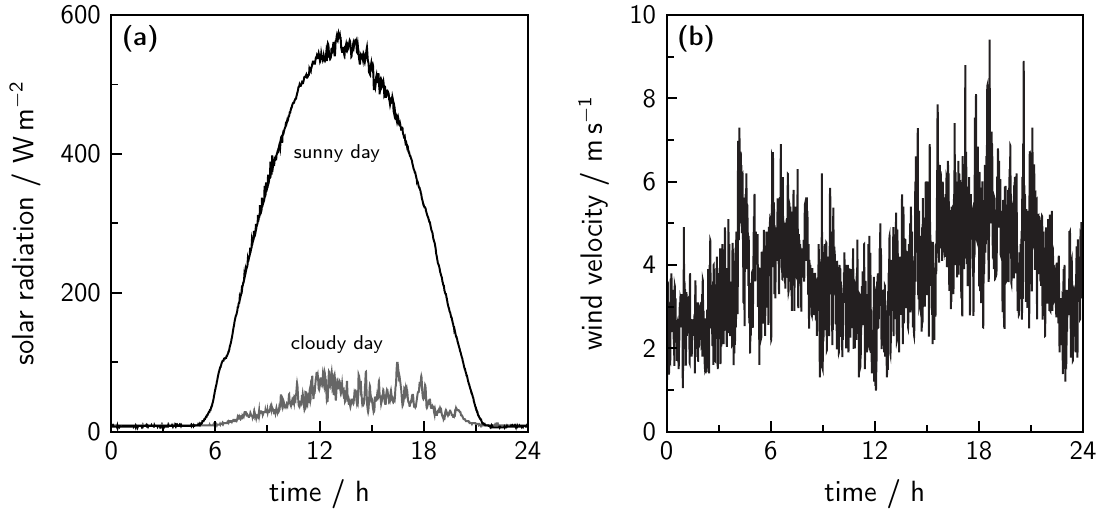
Figure 7. Typical time-related profiles for ( a ) solar radiation and ( b ) wind velocity, measured by the weather station of the Clausthal University of Technology. Though solar radiation peaks around noon, wind velocity shows sinusoidal